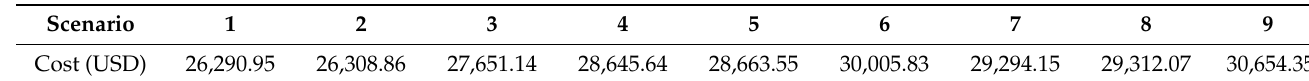
Table 3. Scenarios global